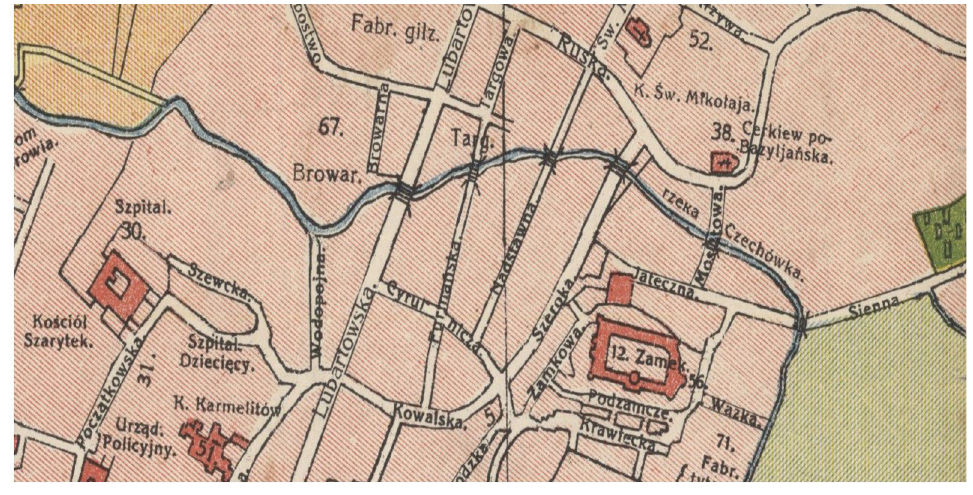
Fig. 8. Szeroka Street on the city map of 1918